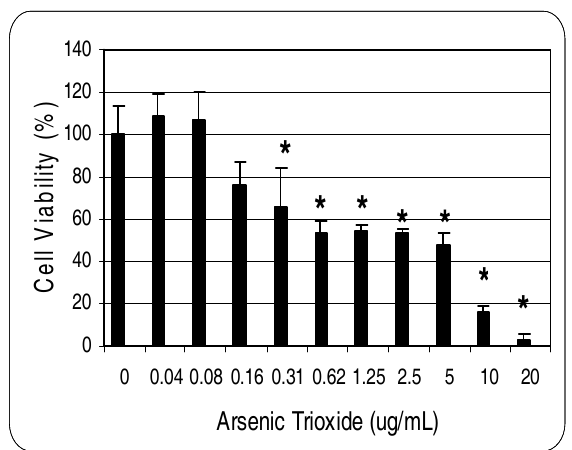
Figure 2: Toxicity of arsenic trioxide to human leukemia (HL-60) cells. HL-60 cells were treated with different doses of arsenic trioxide for 12 hours as indicated in the Materials and Methods. Cell viability was determined based on the MTT assay. Each point represents a mean value and standard deviation of 3 experiments with 6 replicates per concentration. Cell Viability in 5, 10, and 20 µg/mL are significantly different ( p < 0.05) compared to the control according to ANOVA Dunnett’s test.